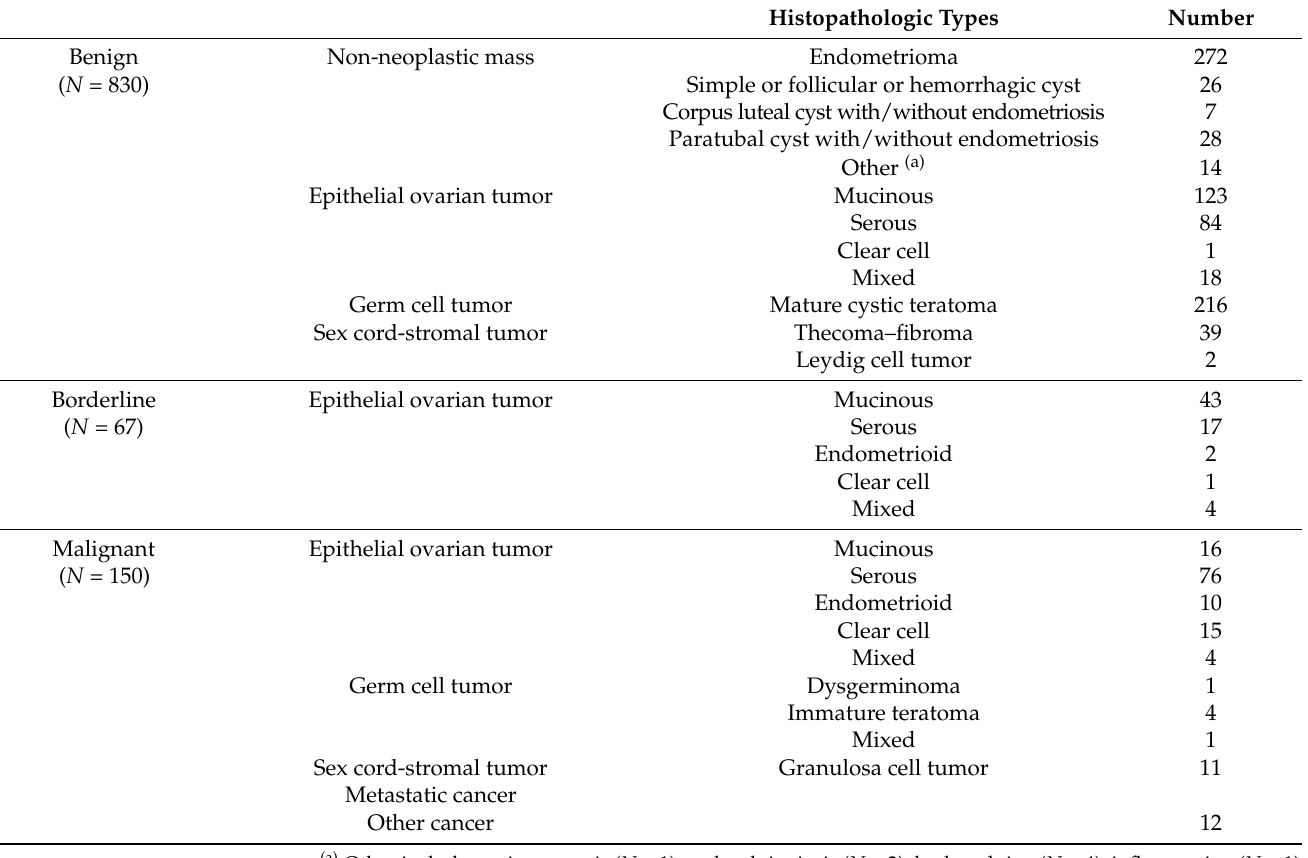
Table 1. Histopathologic types of tumors in the enrolled